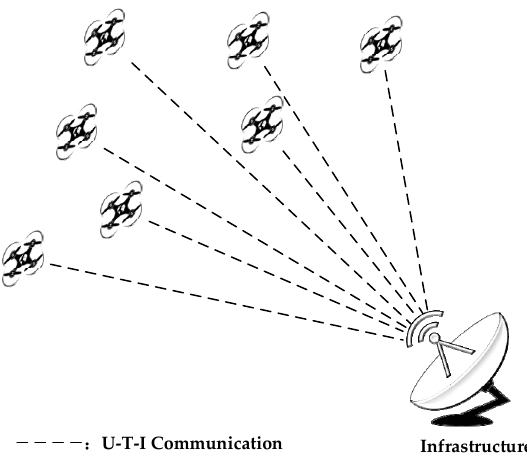
Figure 1. Schematic depicting the centralized communication architecture.